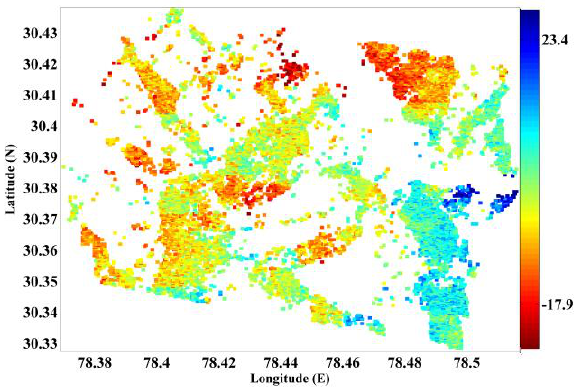
Fig. 4. Time series velocity plot of Tehri region showing PS pixel (colour bar showing velocity in